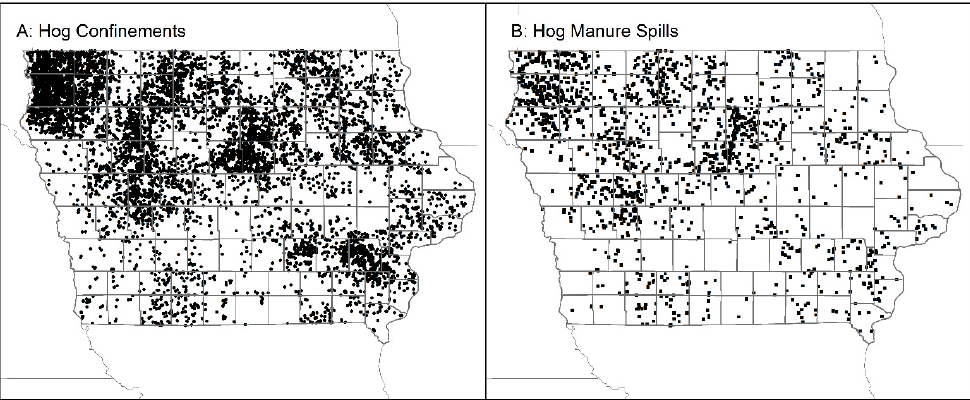
Figure 2. Locations of swine CAFOs ( A ) and swine manure spills ( B ) in Iowa.